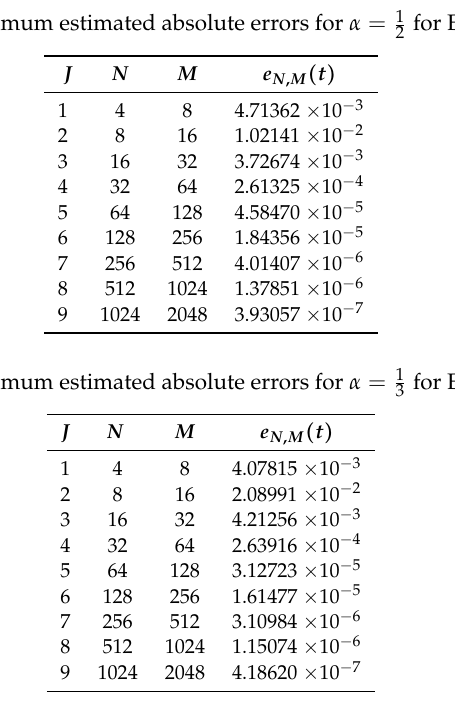
Table 1. Maximum estimated absolute errors for α = 1